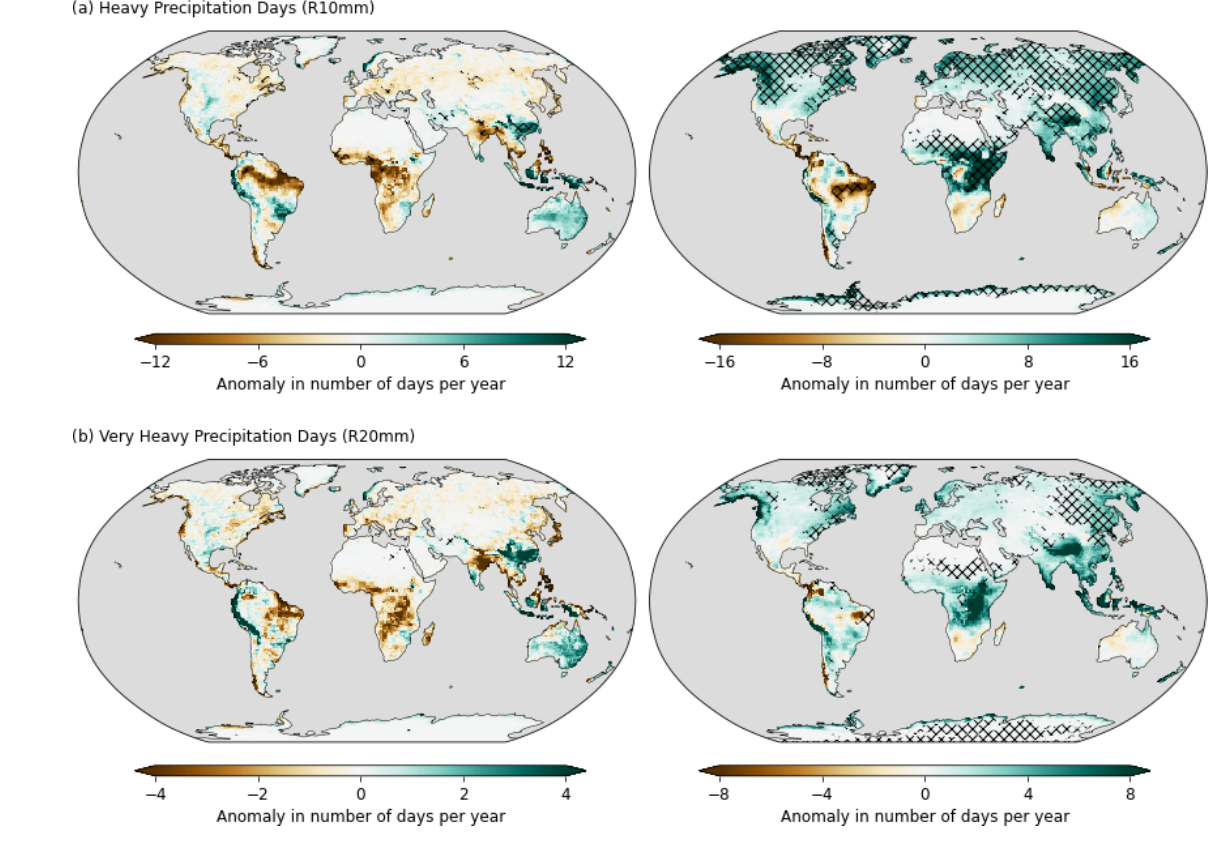
Figure 8. Similar to Fig. 2, but for projected changes in (a) the frequency of days with heavy precipitation (R10mm) and (b) days with very heavy precipitation (R20mm). Hatching indicates significance at the 5% test level using the Student’s t